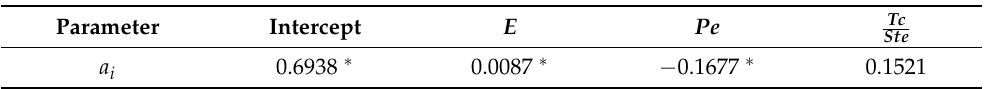
Table 4. Second attempt of the regression analysis to estimate the coefficients, a i , using the linear least-squares approach. Asterisk ( ∗ ) indicates the statistical significance of the coefficient using a t-test with a 95% confidence interval. Other statistics: R 2 = 0.763, Adjusted R 2 = 0.750, F-statistic = 55.95, P(F) = 0.0. Condition number = 1.12 × 10 3 . Parameter E Pe Tc